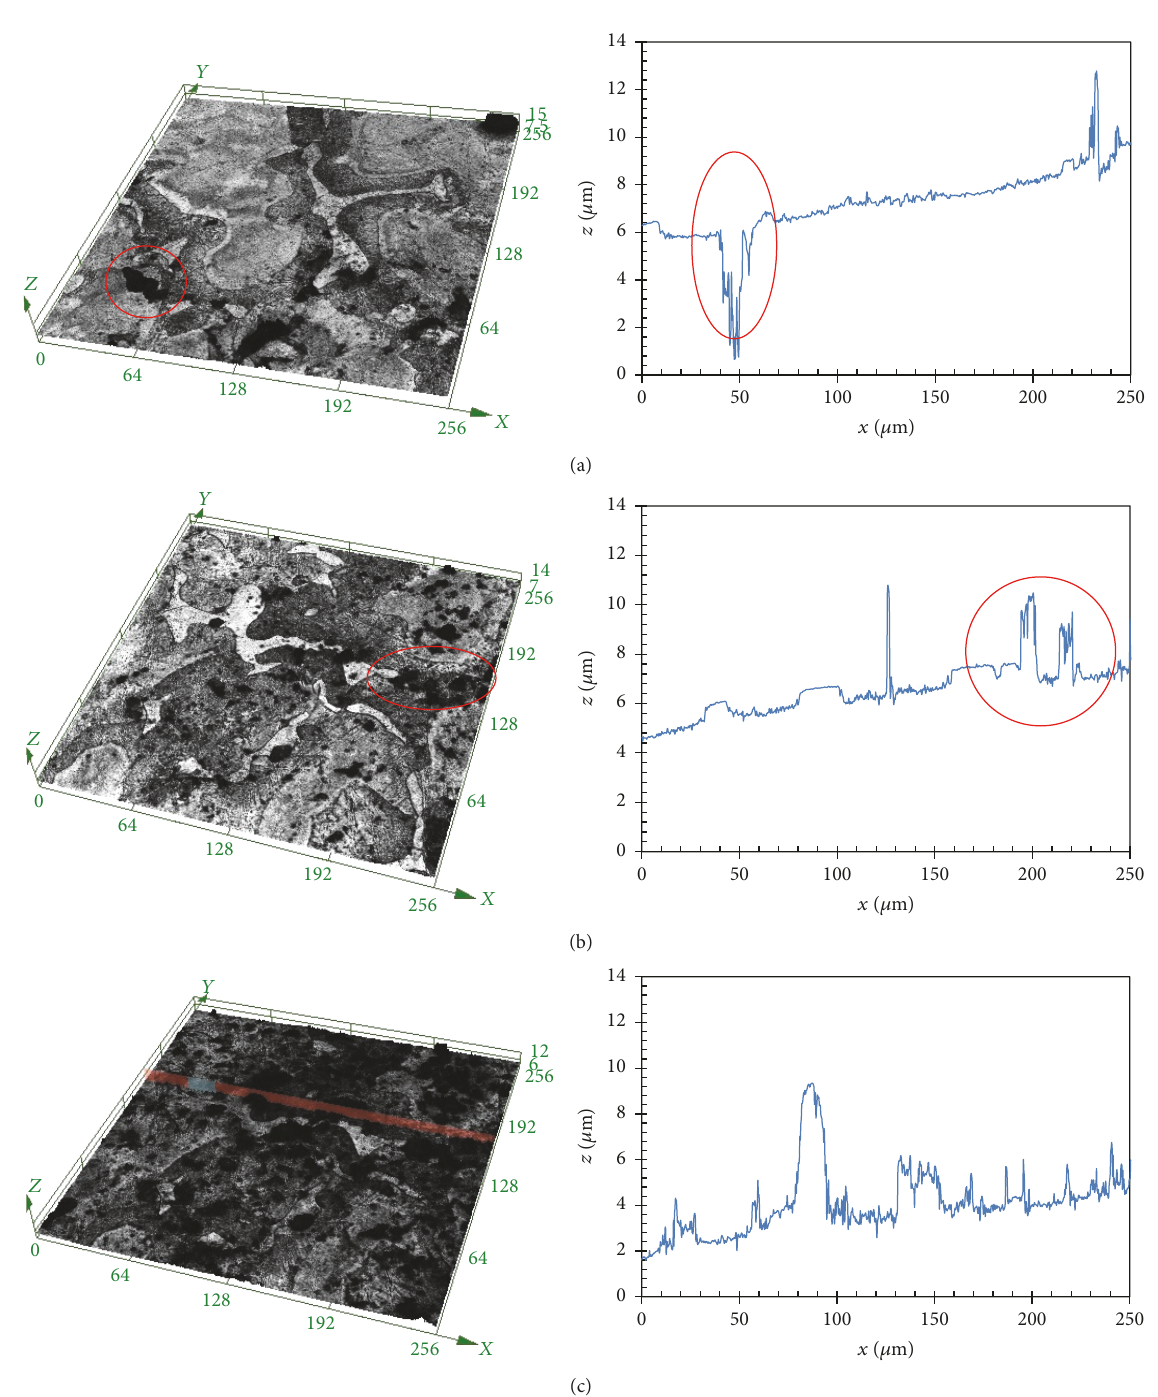
Figure 10: CLSM 3D images and corresponding roughness profiles for the AZ91D immersed in 3.5 wt.% NaCl solution for different times: (a) 6h; (b) 15 h; (c) 72